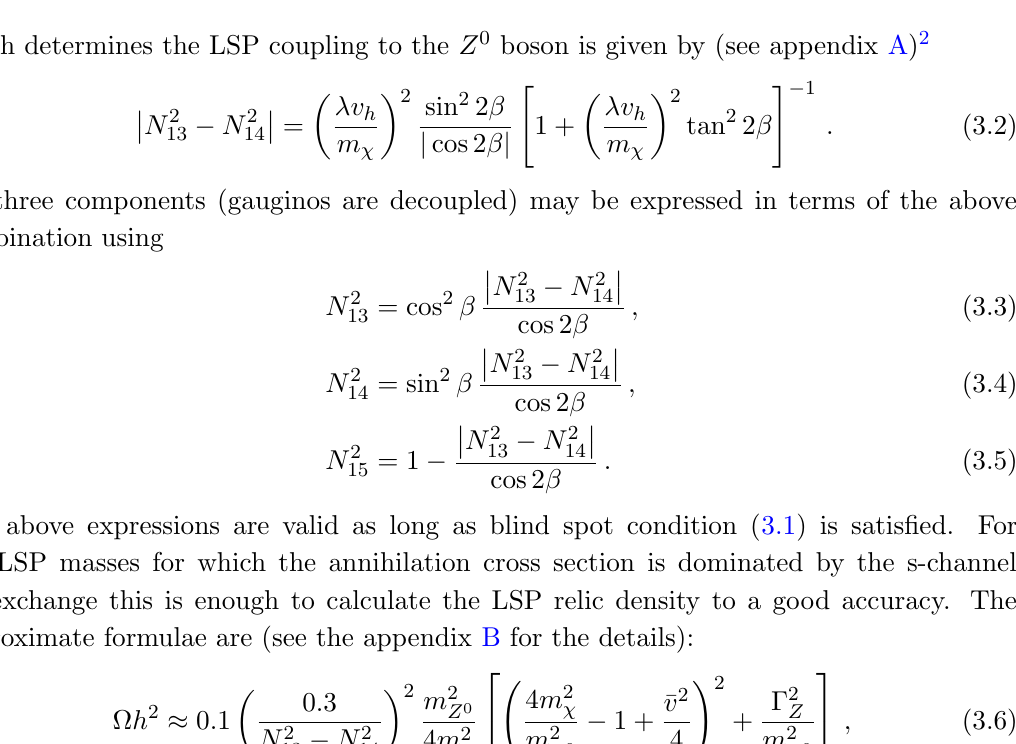
Figure 1 . Contour lines of (cid:10) h 2 (obtained with MicrOMEGAs 4.3.1 [45] and NMSSMTools 5.0.2 [46, 47]) as functions of m LSP and tan (cid:12) for blind spots with decoupled all Higgs particles except the SM-like one. Dashed and dotted blue lines correspond to eq. (3.6) and (3.7), respectively, after substituting (3.2), for (cid:10) h 2 = 0 : 12. Red region depicts the points with m < 103 GeV which are (cid:31) (cid:6) 1 ruled out by LEP [49]. Yellow area is forbidden because of eq. (3.9), whereas green/cyan one due to LUX/IceCube (IC) limits on spin-dependent LSP interaction with nucleons. Vertical red lines correspond to (from left to right) m LSP = m = 2 ; m h = 2 ; m W ; m t Z 0